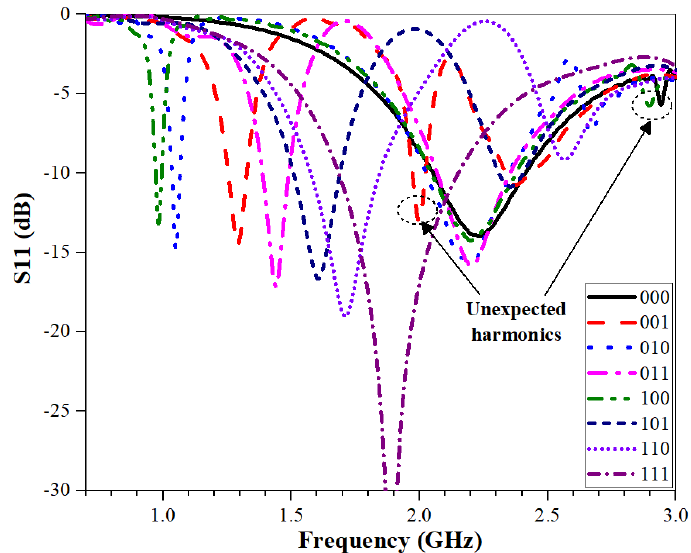
Figure 8. Simulated reflection coefficient at different states of the proposed 3-bit frequency reconfigurable MMA.